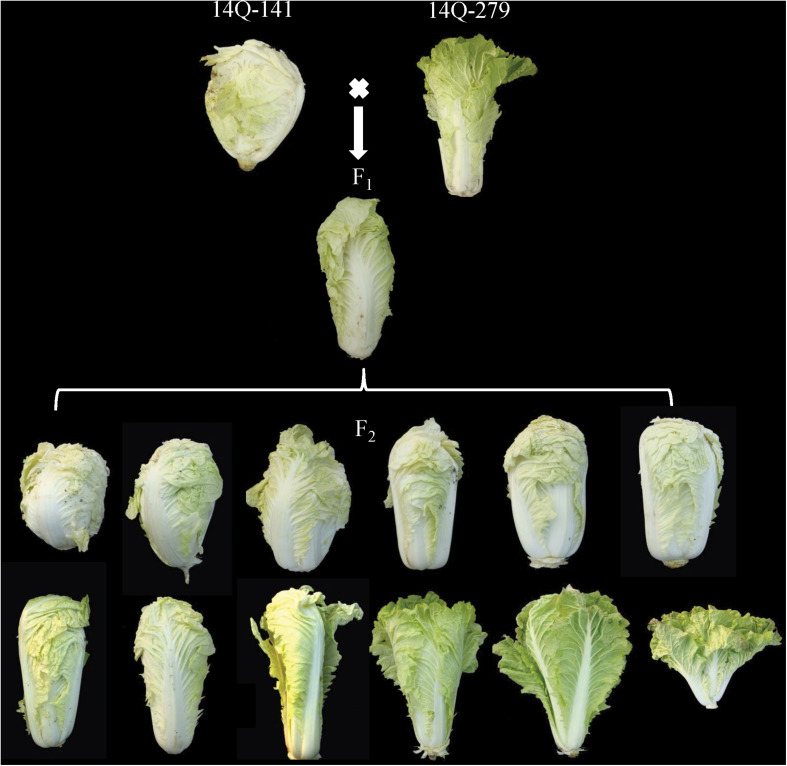
Parents, F1 and representatives in F2 population.